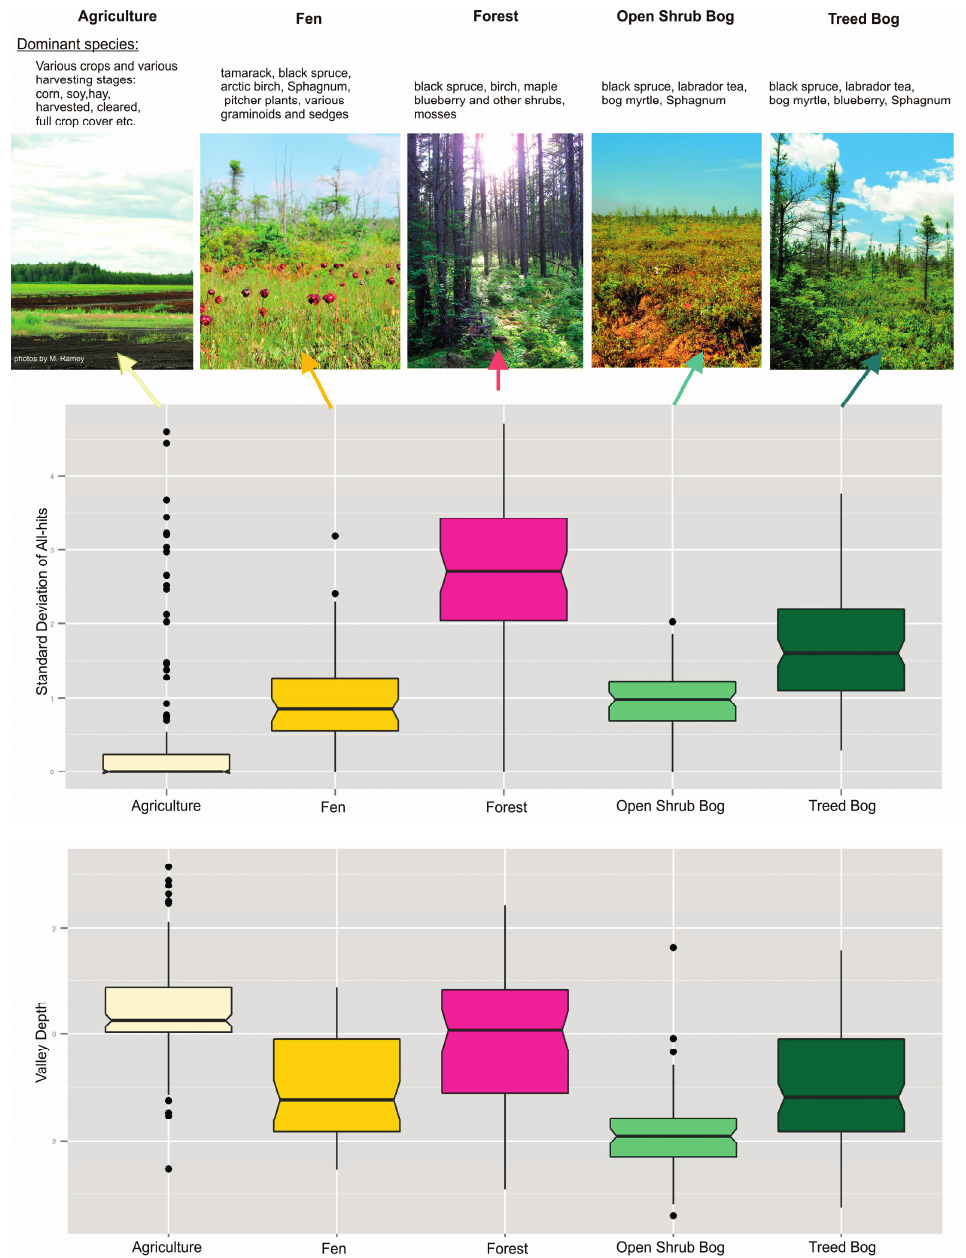
Figure 2. Peatland and upland classes at Alfred Bog. Top panel indicates dominant species found in each class with a corresponding photo. The middle panel shows boxplots of the standard deviation of Height Vegetation classified points in each class. Boxplots in the bottom panel indicate the Valley Depth DEM derivative in each class. Valley Depth is a LiDAR derivative that measures the vertical distance to an inverted channel network and indicates the local magnitude of relief. If notches in boxplots do not overlap there is strong evidence that their medians are statistically different [34]. Photos by Marisa Ramey